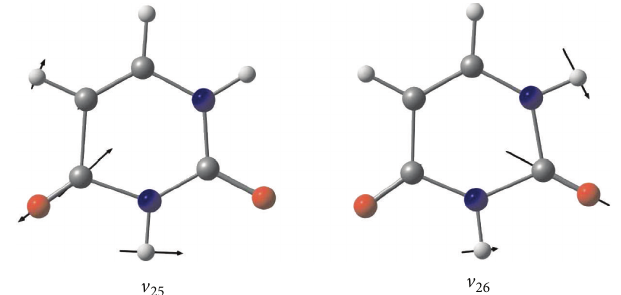
Figure 5: Atom vector displacements of the ] C = O + 𝛿 N-H modes ] ] 25 and 26 .